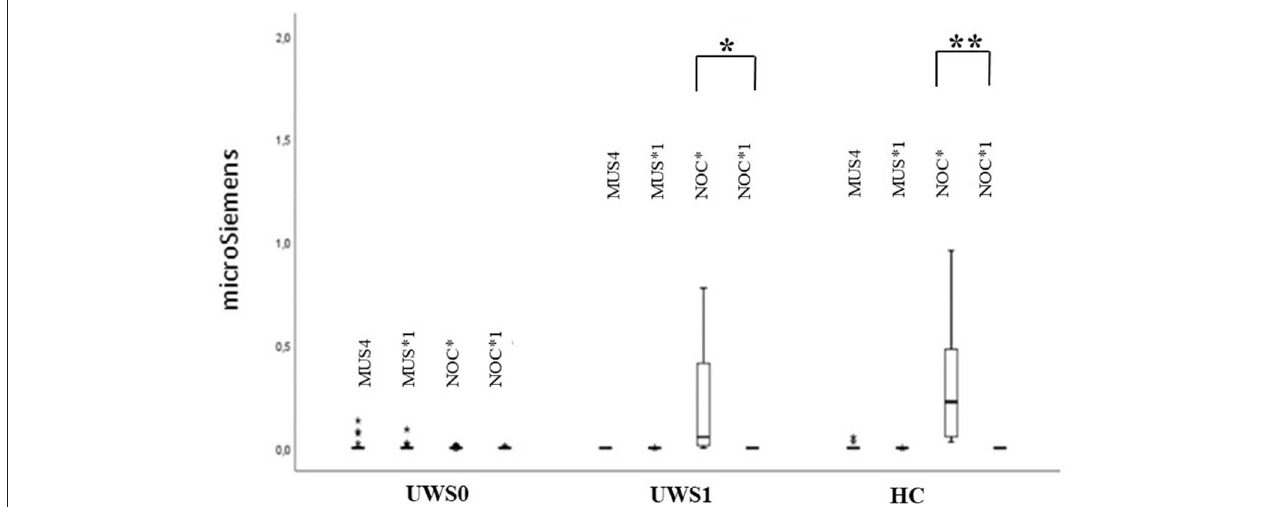
FIGURE 6 | Sequence B: boxplot of GSR magnitude. MUS4 vs. MUS1* and NOC* vs. NOC1* were compared. Only in the HC and UWS1 groups a significant difference between NOC* and NOC1* was observed (***HC: Z